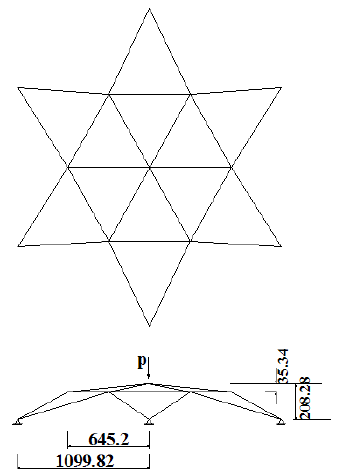
Figure 2. Space truss with 24 – members, all dimensions are in mm [28] .